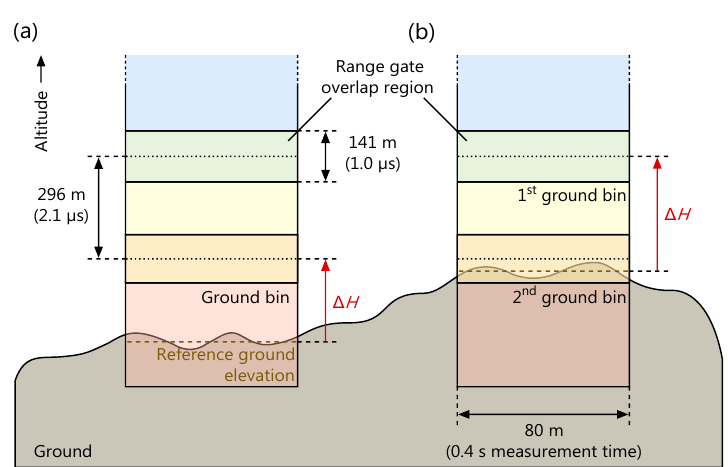
Figure 3. Detection of ground signals with the A2D wind lidar. The sketch shows the vertical position of three neighbouring range gates (blue, yellow and red boxes) with respect to the ground. The ground return signals are either contained in only one range bin (a) or distributed over two range bins due to the range gate overlap (here shown for the Mie channel as green and orange areas) as well as varying elevation of the ground surface within one measurement (b) . (cid:49)H denotes the atmospheric contribution to the signal obtained from the ground bin(s). The given heights of 296 and 141m are related to the A2D off-nadir angle of 20 ◦